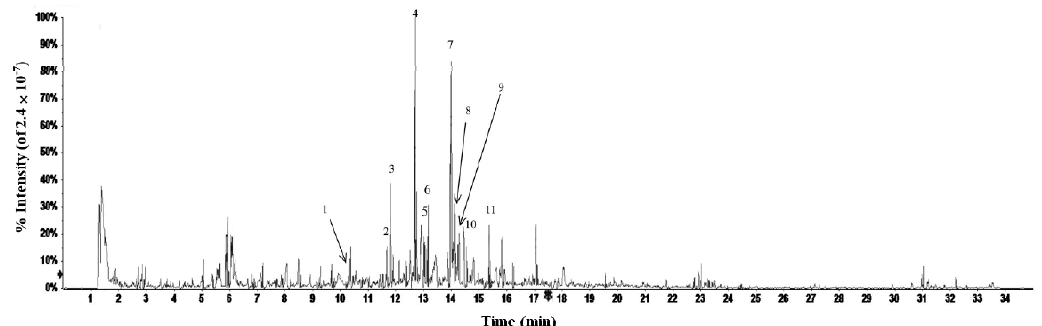
Figure 5. Total ion flow chromatogram of sample extract. Peaks 1–11 are identified in Table 1.